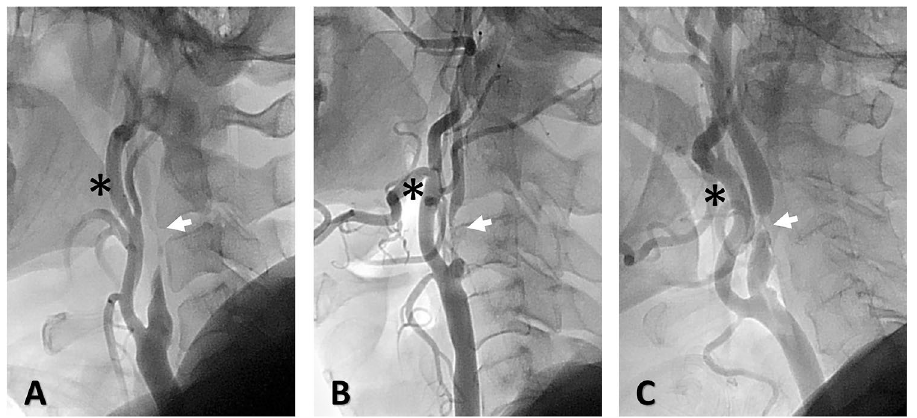
Figure 1. Illustration of different variants of carotid stenosis. ( A ) Carotid artery near occlusion with full collapse ( B ) Carotid artery near occlusion without full collapse ( C ) Severe conventional carotid stenosis without near occlusion. Black star: external carotid artery. White arrow: internal carotid